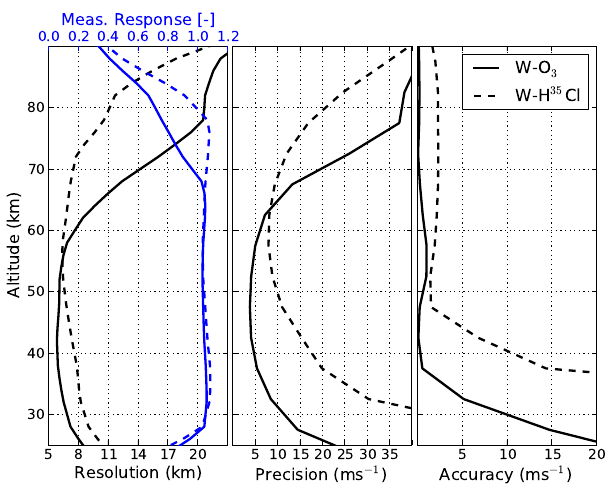
Fig. 4. Left panel: vertical resolution (dark line) and measurement response (blue line) for line-of-sight wind profiles retrieved from the O 3 spectral line (full lines) and from the H 35 Cl triplets in band B (dashed lines). Central panel: estimates of line-of-sight wind single retrieval precision derived from the O 3 spectral line (full line) and the H 35 Cl triplets (dashed line). Right panel: same as central panel but for the